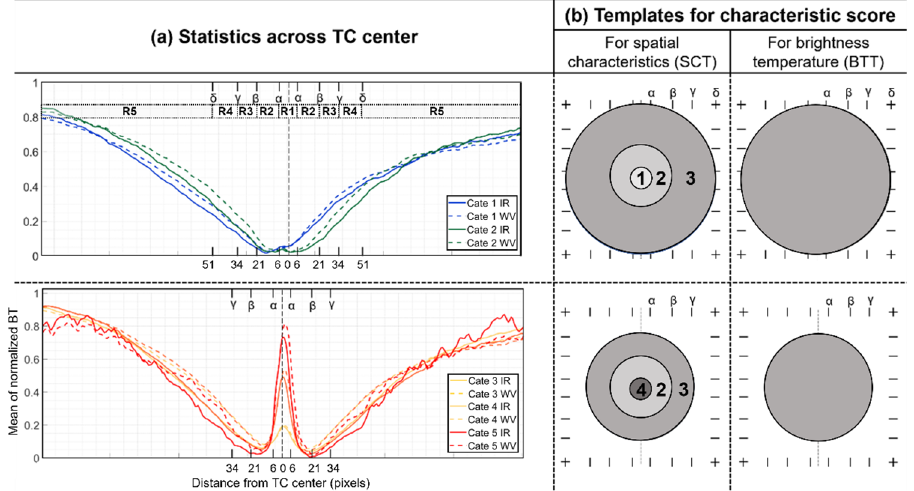
Figure 5. Two spatial templates to calculate a score matrix, where ( a ) represents the morphological characteristics around a tropical cyclone center by intensity category. To compare the spatial distribution of the events, they were normalized into 0–1. The solid line in ( a ) shows a brightness temperature (BT) trend in the infrared channel and the dashed line shows a BT trend in the water vapor channel. ( b ) represents the templates for spatial characteristics and BT of a tropical cyclone by intensity category. The size and value of each template are decided based on statistics across the tropical cyclone center. R1–R5 (distance ranges from the tropical cyclone center) were determined using α , β , γ , and δ , representing a distance of 6, 21, 34, and 51 pixels, respectively. Each pixel size corresponds to approximately 4 km. The values of the spatial characteristic templates consist of (1,2,3) and (4,2,3) toward the outside for intensity categories 1 and 2 and 3–5, respectively. Using SCT- and BTT-based matrices, an SCM was extracted to specify an ROI, a candidate region for determining the TC center. One is a correlation matrix containing two-dimensional correlation coefficient values calculated between satellite observations and SCT (referred to as CORRmat ), and the other is a BT matrix containing an average of the BT values included in the BTT (referred to as BTmat ). CORRmat was normalized between 0 and 1, whereas BTmat was inversely normalized between 0 and 1. SCM is defined by linearly combining the two matrices. The empirically determined coefficients of BTmat were 0.3 for a weak TC (categories 1 and 2) and 1.0 for a strong TC (categories 3–5), respectively.